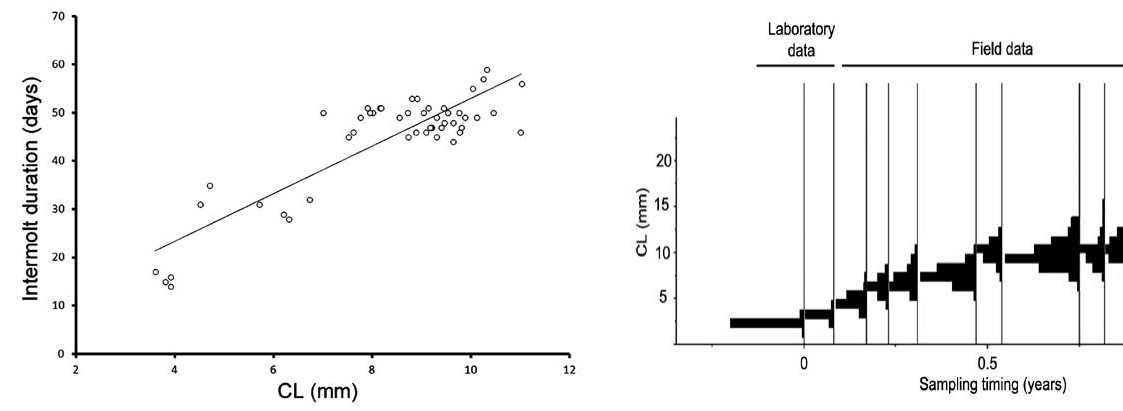
Fig. 5. – Size (CL) frequency distribution of young of the year of Munida gregaria in San Jorge